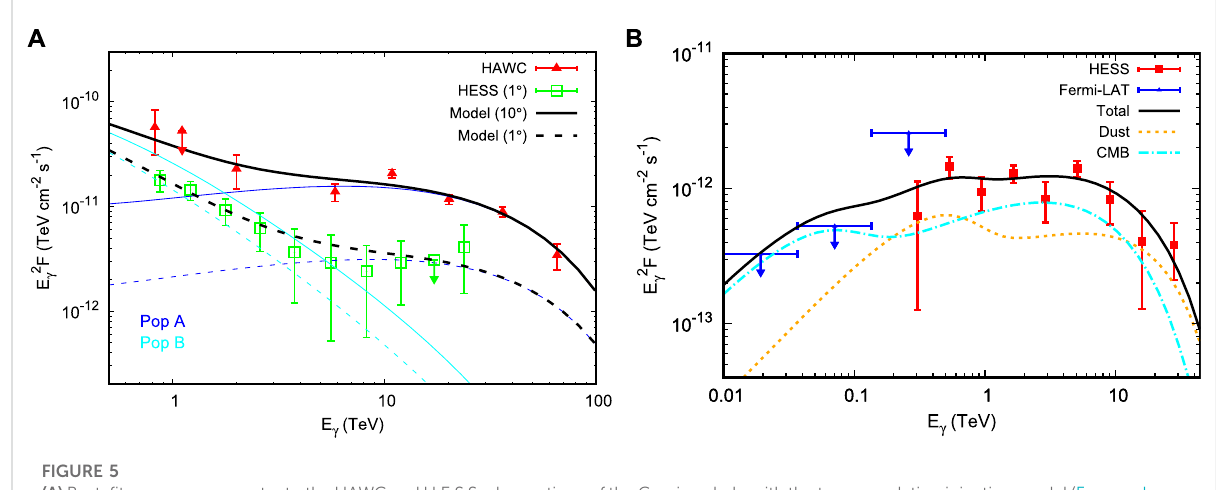
FIGURE 5 (A) Best- fi tgamma-ray spectrato theHAWCandH.E.S.S.observationsoftheGemingahalowiththetwo-population injectionmodel(Fangand Bi,2022).PopArepresentsthefreshlyacceleratedelectronsthatescapefromthePWNthroughrapidout fl ows,whilePopBrepresentstheelectrons trapped longer in the PWN before escaping. The black solid (dotted) line is the total spectrum within 10 ° (1 ° ) around the pulsar, which fi ts the HAWC (H.E.S.S.) spectrum. (B) Best- fi t gamma-ray spectra to the H.E.S.S. data of HESS J1831 − 098 with a single ECPL injection model (Fang et al., 2022). The two sub-components of scattering the dust photons and CMB photons are also separately shown. The Fermi-LAT ULs are shown for comparison but not used in the fi tting